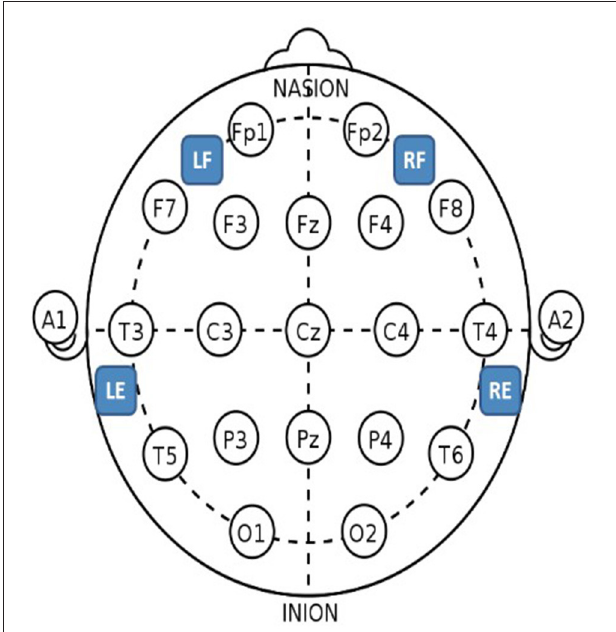
FIGURE 4 | Epilog sensor placement locations with the standard International 10–20 system as reference. For the forehead locations, LF is left-forehead closest to F7, RF is right-forehead closest to F8, and the Epilog sensors were placed as far from forehead/eye muscles as possible. For the behind-the-ear locations, LE is behind left ear closest to T5, and RE is behind right ear closest to T6, and the Epilog sensors were placed as high up as possible over the mastoid while still being below the hairline, making sure placement was not directly over the neck